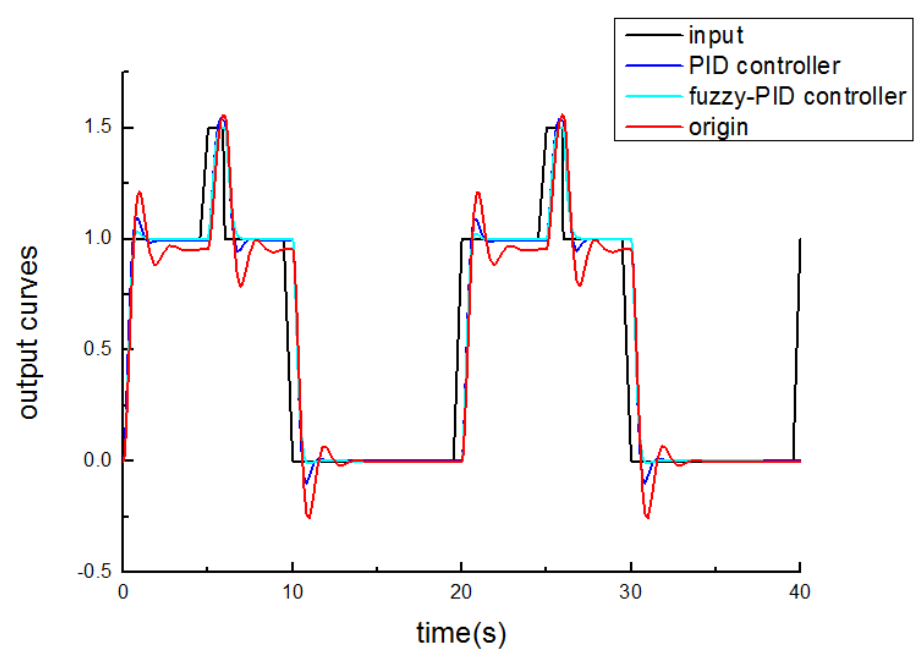
Figure 9. Response curves of different control methods.